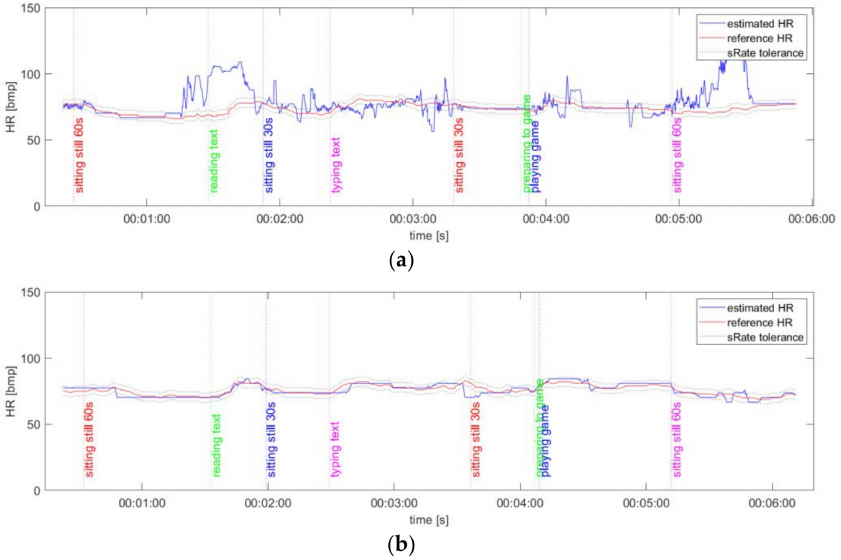
Figure 4. An example of HR time-series plots for algorithm No.1 (PSD) and ExG signal representation: ( a ) video No.5; ( b ) video No.9.